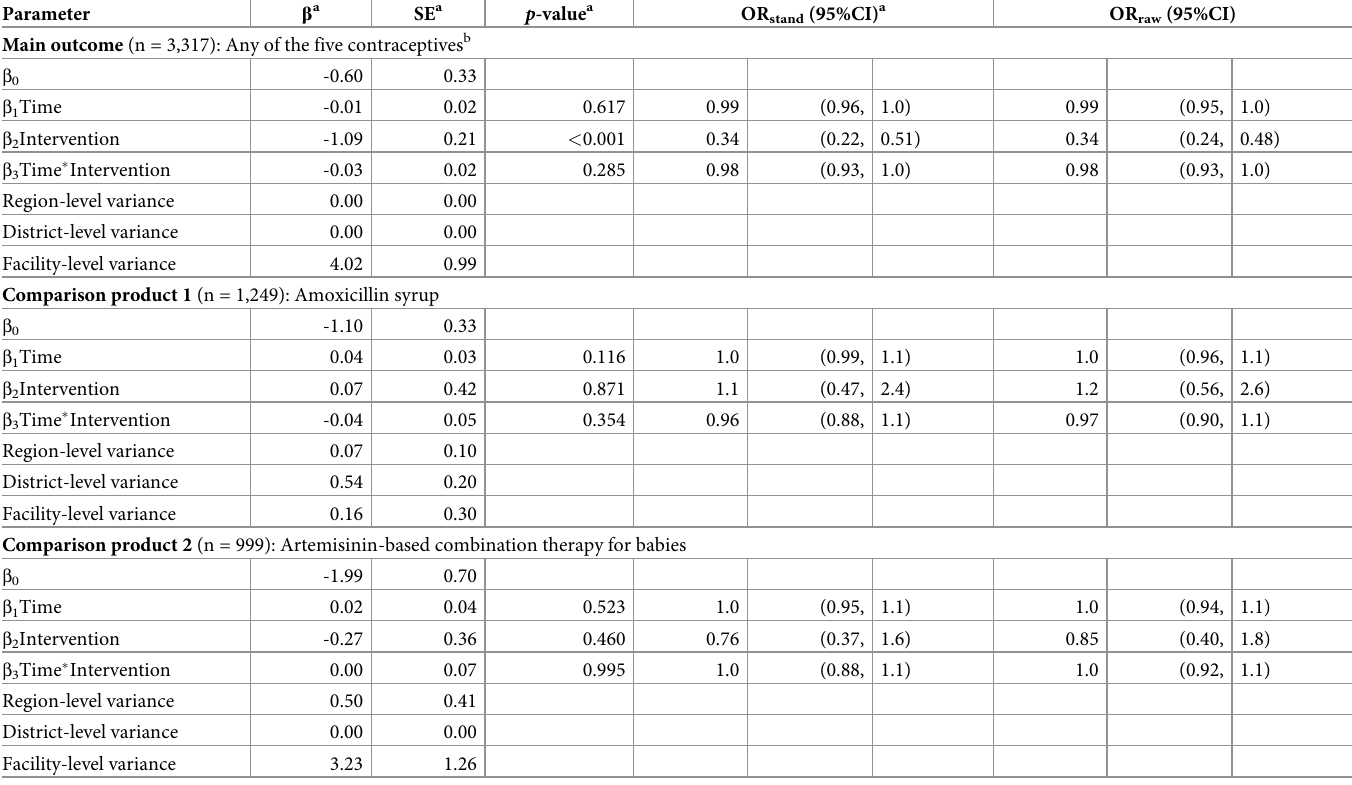
Table 1. The effect of the Informed Push Model intervention on odds of any monthly stockout for contraceptive and comparison products, in Senegalese health facilities.